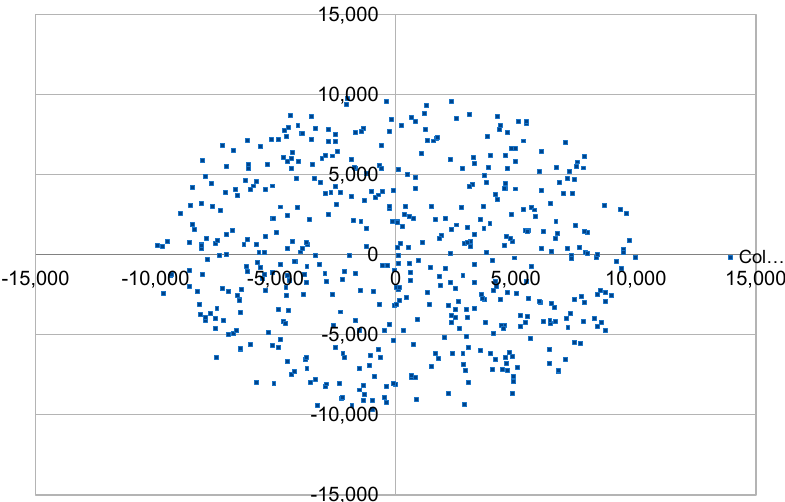
Figure 1. Simulation scenario with disc end node spatial distribution.